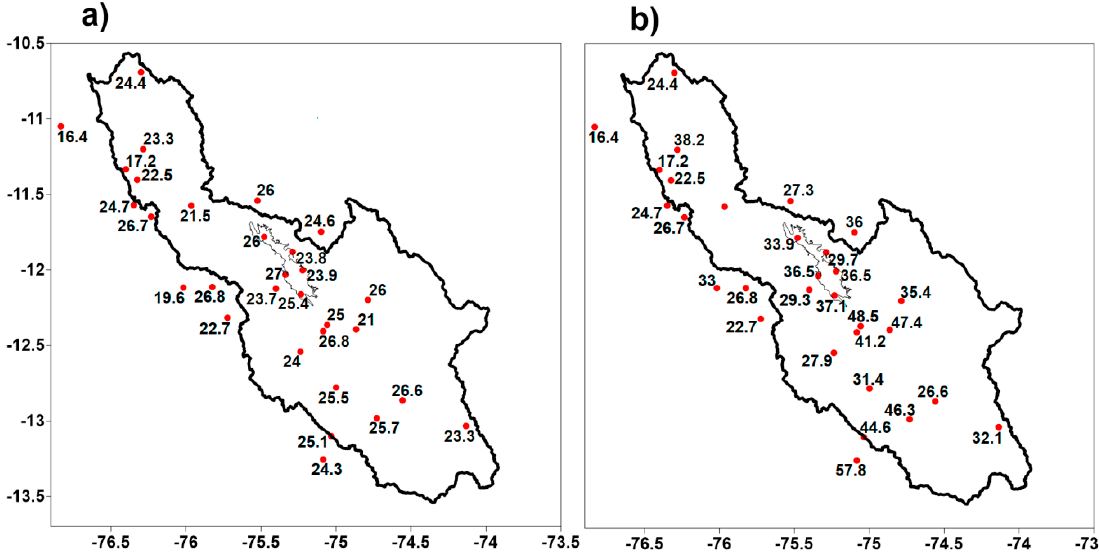
Figure 6. Spatial distribution of the mean ( a ) and maximum ( b ) accumulated rainfall observed in mm/day. in